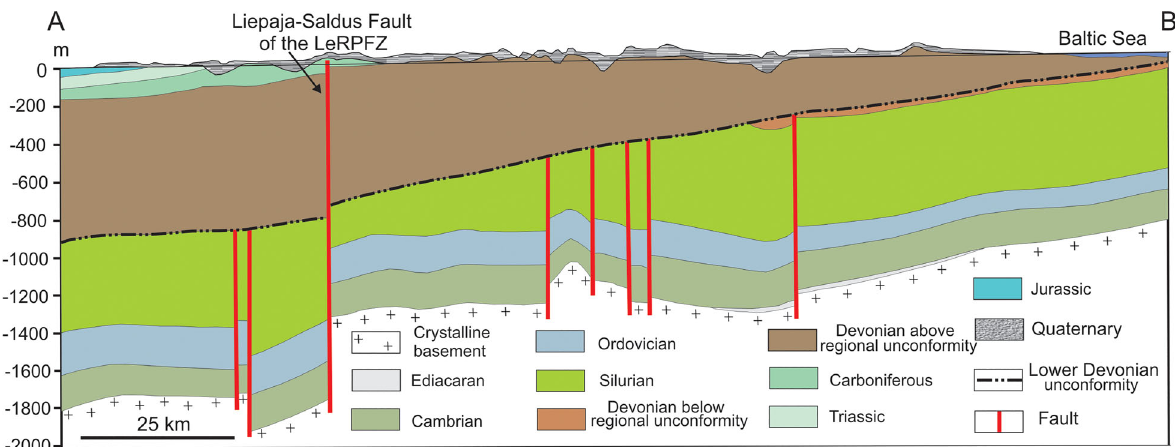
Fig. 4. Submeridional geological cross section of western Latvia across the Liepaja–Saldus fault of the LeRPFZ (modified after Brangulis & Kanev 2002). For location see Fig. 1.